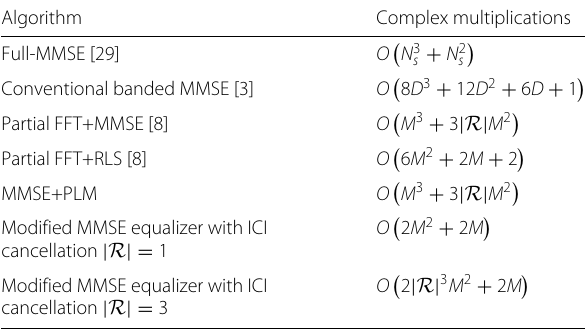
Table 1 Complexity comparison between different equalization algorithms